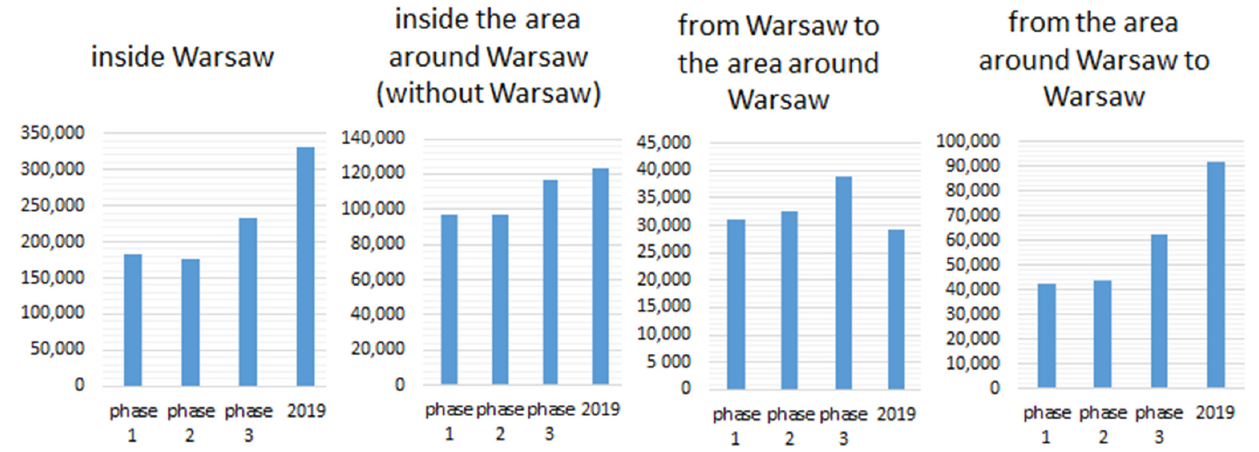
Figure 3. Numbers of trips during the pandemic phases in 2020 and the 2019 baseline period. During the morning peak, the number of trips within Warsaw was noticeably lower.